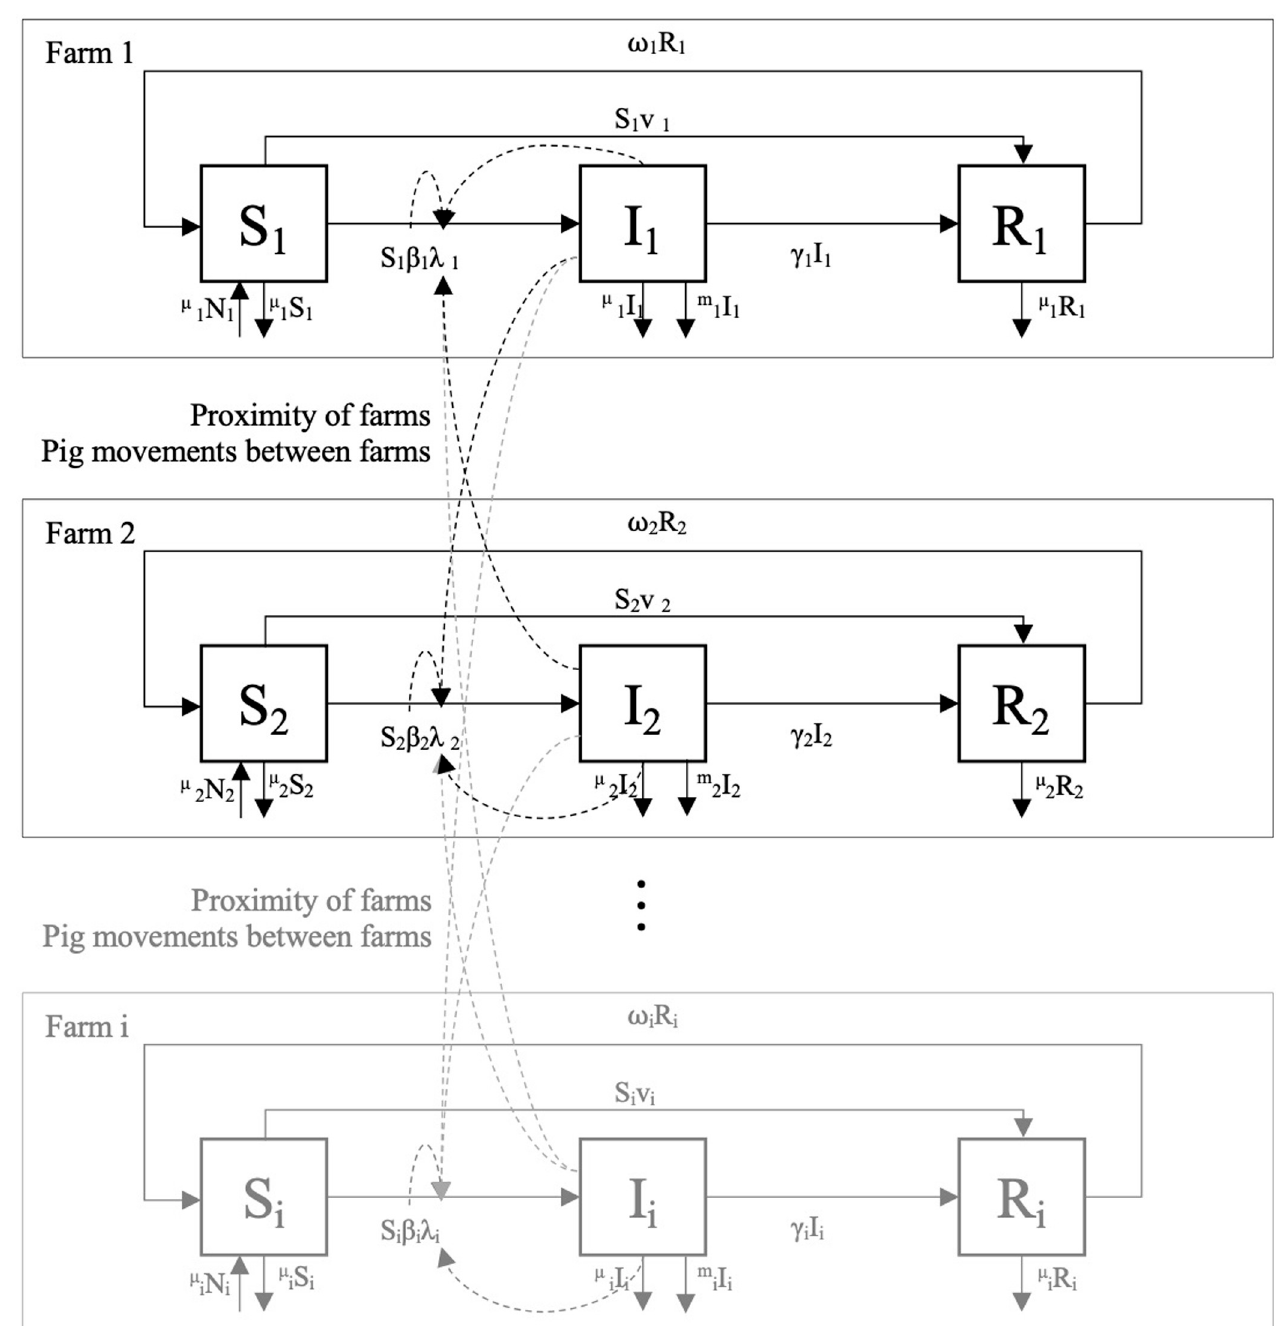
Fig 1. Conceptual flow of our SIR